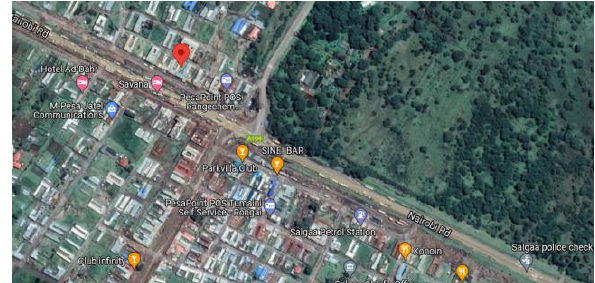
Figure 1 . Google Maps Capture of